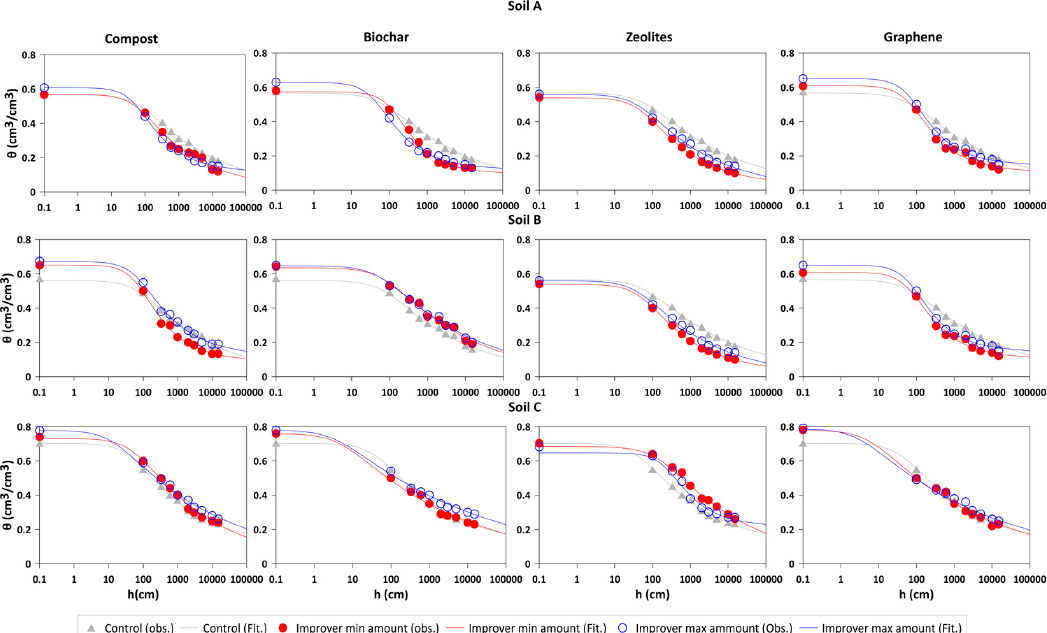
Figure 2. WRCs of all the treatments for ( upper panel ) Soil A, ( middle panel ) Soil B, and ( lower panel ) Soil C. Symbols refer to the observed median values (obs.), while lines refer to the fitted van Genuchten model (fit.). The min amount was 5% dry weight for compost, biochar, and zeolites, and 0.5% dry weight for graphene. The max amount was 10% dry weight for compost, biochar, and zeolites, and 1% dry weight for graphene.